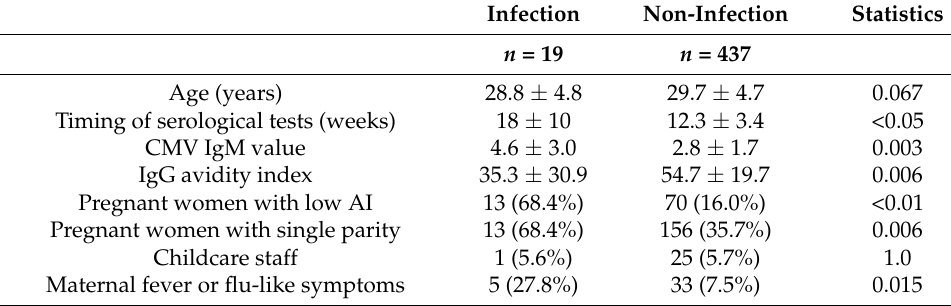
Table 4. Comparison between the infection and non-infection